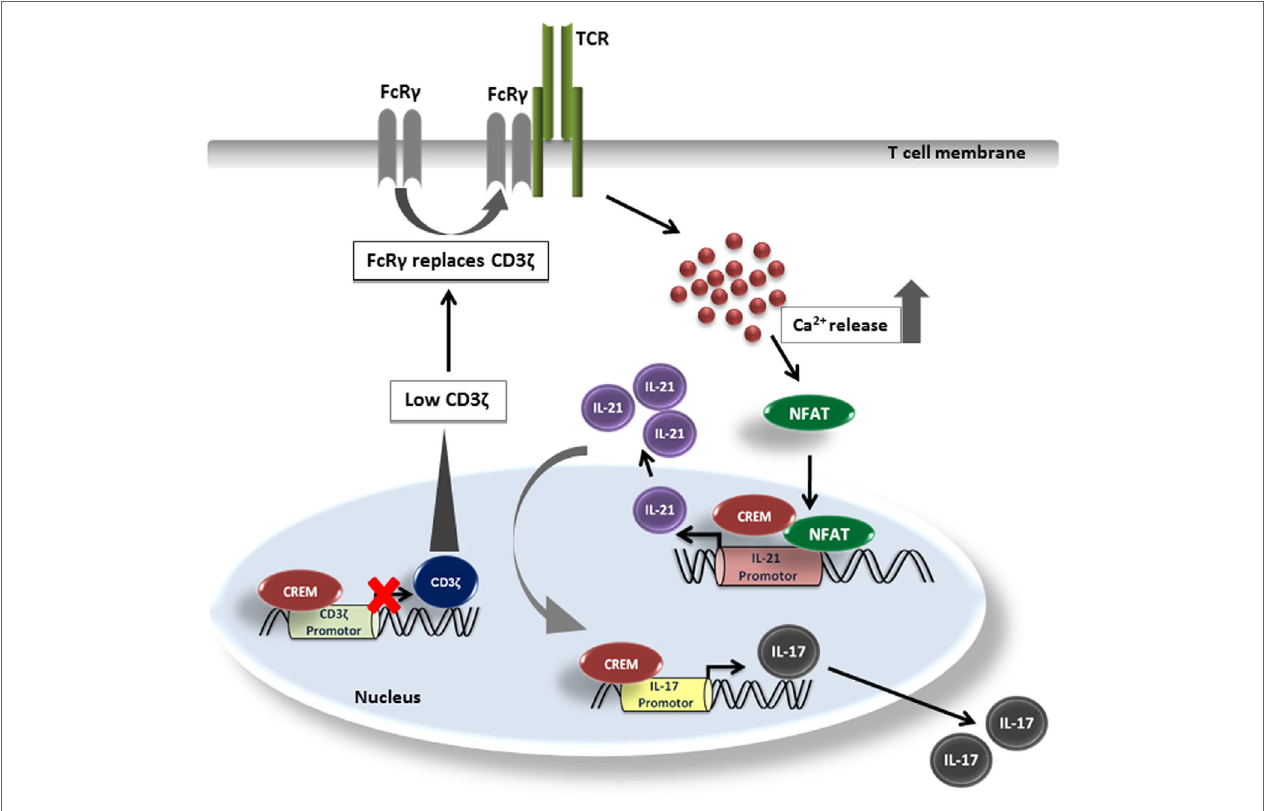
FigUre 6 | Model of il-21 induction by caMP-responsive element modulator alpha (creM α ) . CREM α represses CD3 ζ chain expression. CD3 ζ chain, which normally transduces TCR signals into the cell, can be replaced by FcR γ . FcR γ signals much stronger than the CD3 ζ chain. Therefore, higher amounts of Ca 2 + are released, which lead to an enhanced binding of NFATc2 to the IL-21 promoter and subsequently induces IL-21 expression. At the same time, CREM α also binds to the half-CRE site in the IL-21 promoter, which is only part due to the low CD3 ζ expression as pathways downstream of the TCR complex signaling must be also involved. CREM α likewise binds to the IL-17 promoter and increases IL-17 expression while IL-21, to some extent, supports generation and stabilization of the IL-17